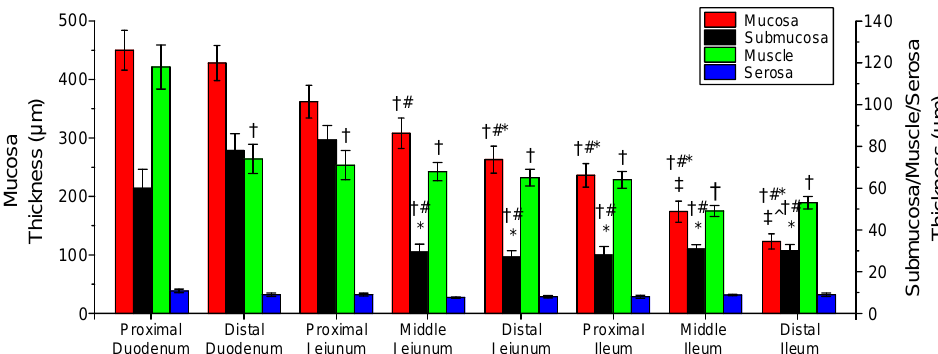
Figure 10. Thickness of the mucosa, submucosa, muscle, and serosa in the small intestinal segments. Symbols †, #, *, ‡, and ^ denote significant difference vs. proximal duodenum, distal duodenum, proximal jejunum, middle jejunum, and distal jejunum.